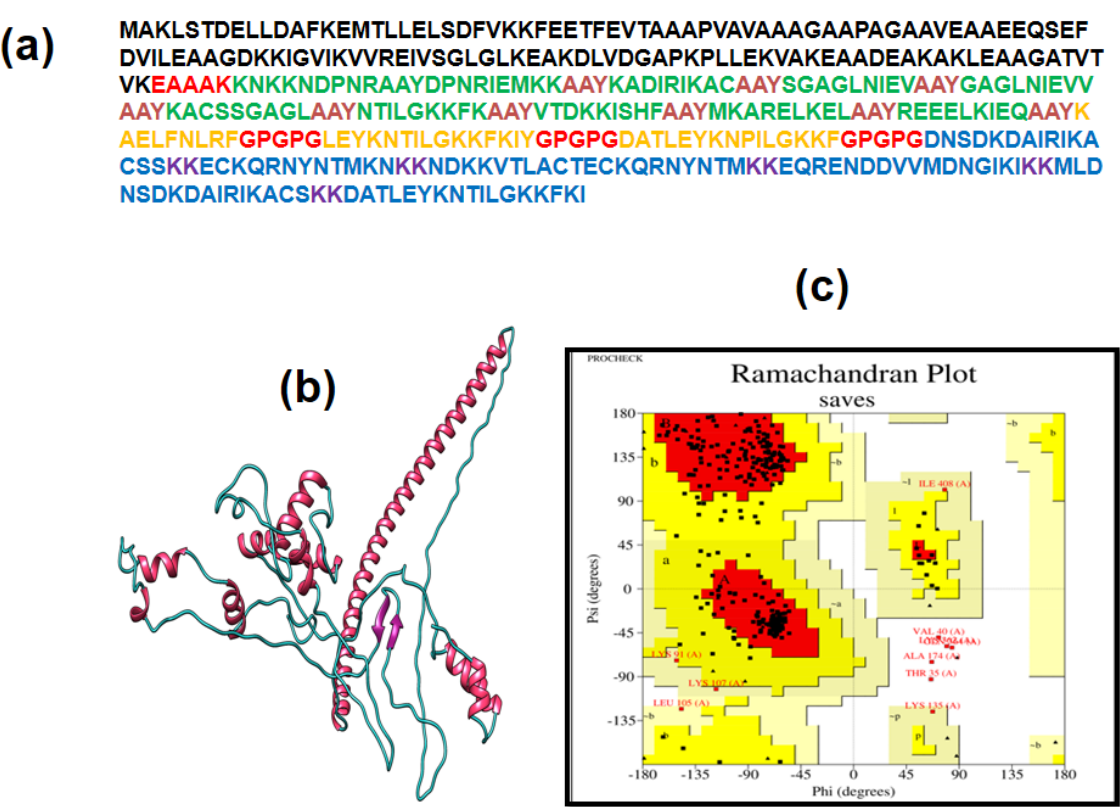
Figure 3. ( a ) Multiple epitope vaccine sequence structure (adjuvant, EAAK, CTL, AAY, GPGPG, HTL, LBL, and KK were labeled with black, red, green, hot pink, red, orange, blue, and dark purple respectively). ( b ) Refined structure of MEV 3D structure (helix, beta strands, and coils are represented in hot pink, purple, and cyan). ( c ) Ramachandran plot analysis of Saves shows that 86.6% residues are within a favorable region.